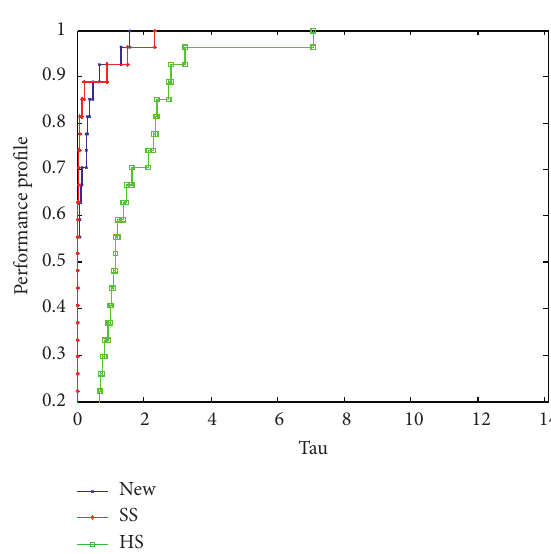
Figure 3: Performance profiles of the number of iterations.